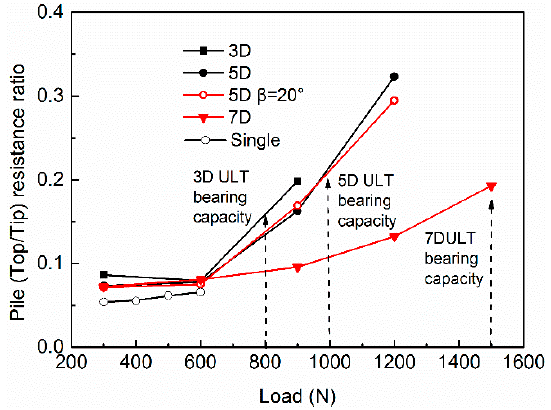
Figure 9. The variation in the pile tip resistance ratio of the symmetrical batter pile.